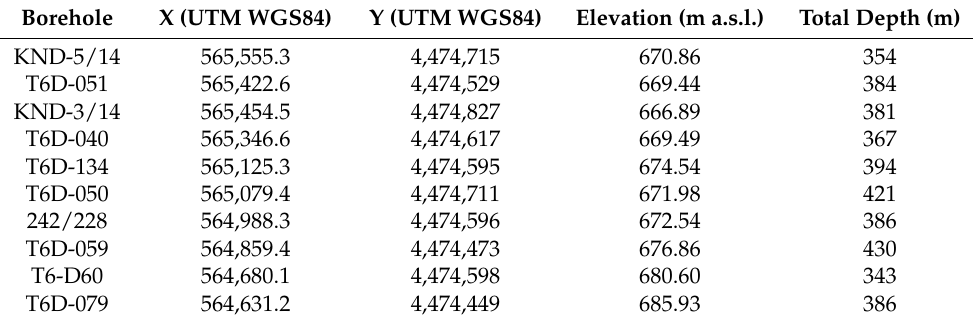
Table 2. Coordinates (UTM WGS84,34N), elevation, and depth of selected boreholes. Borehole X (UTM WGS84) Y (UTM